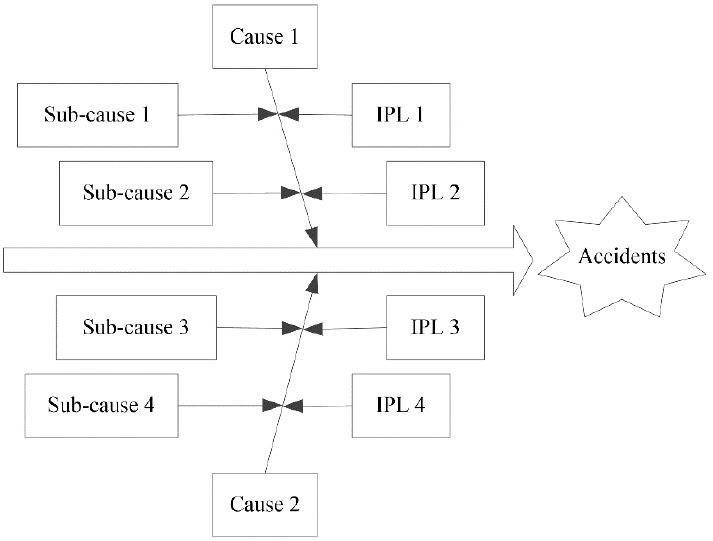
Figure 2. Cause-and-effect-LOPA diagram.